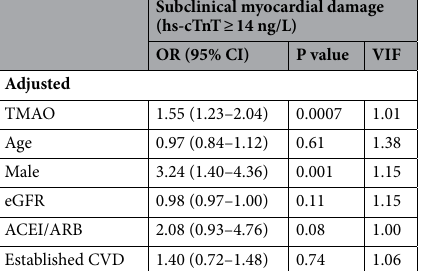
Table 3. Adjusted odds ratios (OR) using variables with P-value < 0.3 based on univariate analysis. Abbreviations as in Table